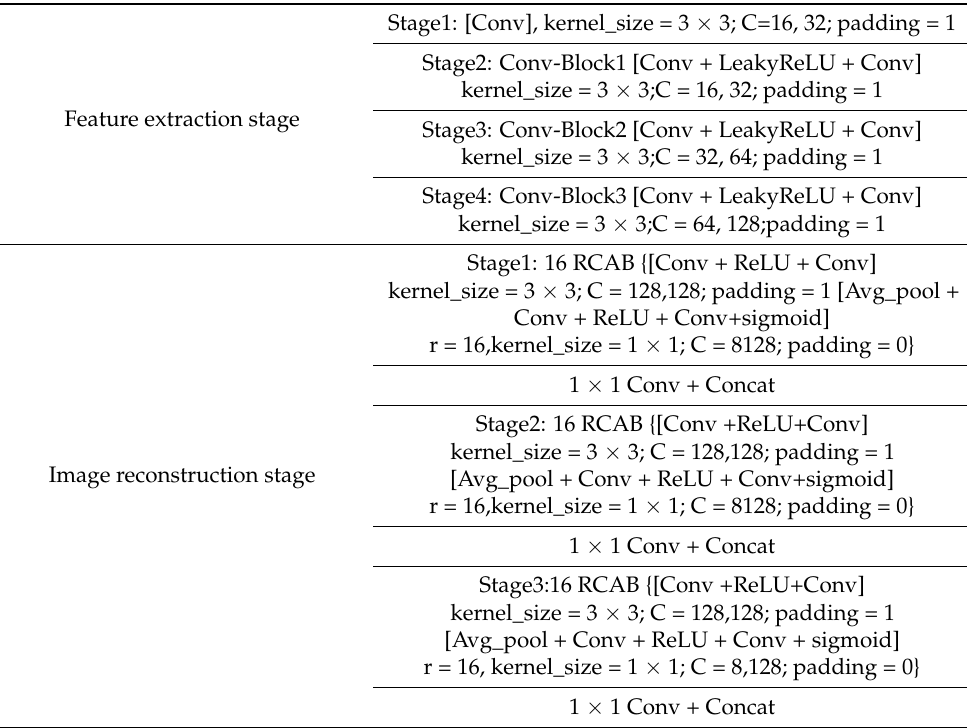
Table 2. The detail experimental parameters of the